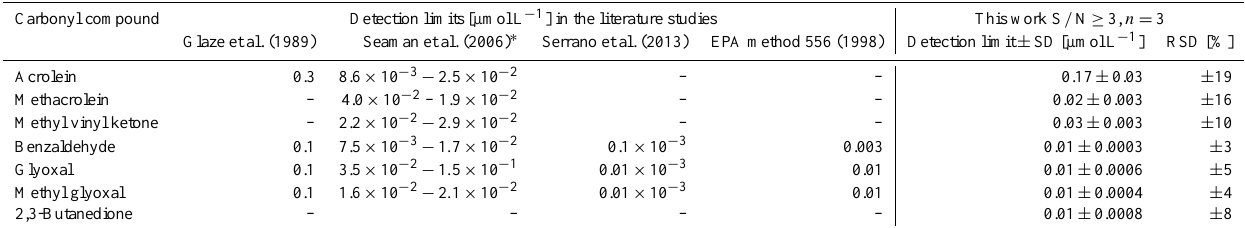
Table 3. Detection limits of the carbonyl compounds determined in the present study with GC/MS (SIM) and in the literature. Carbonyl compound Detection limits [µmolL − 1 ] in the literature studies This work S / N ≥ 3, n = 3 Glaze et al. (1989) Seaman et al. (2006) ∗ Serrano et al. (2013) EPA method 556 (1998) Detection limit ± SD [µmolL − 1 ] RSD [%]